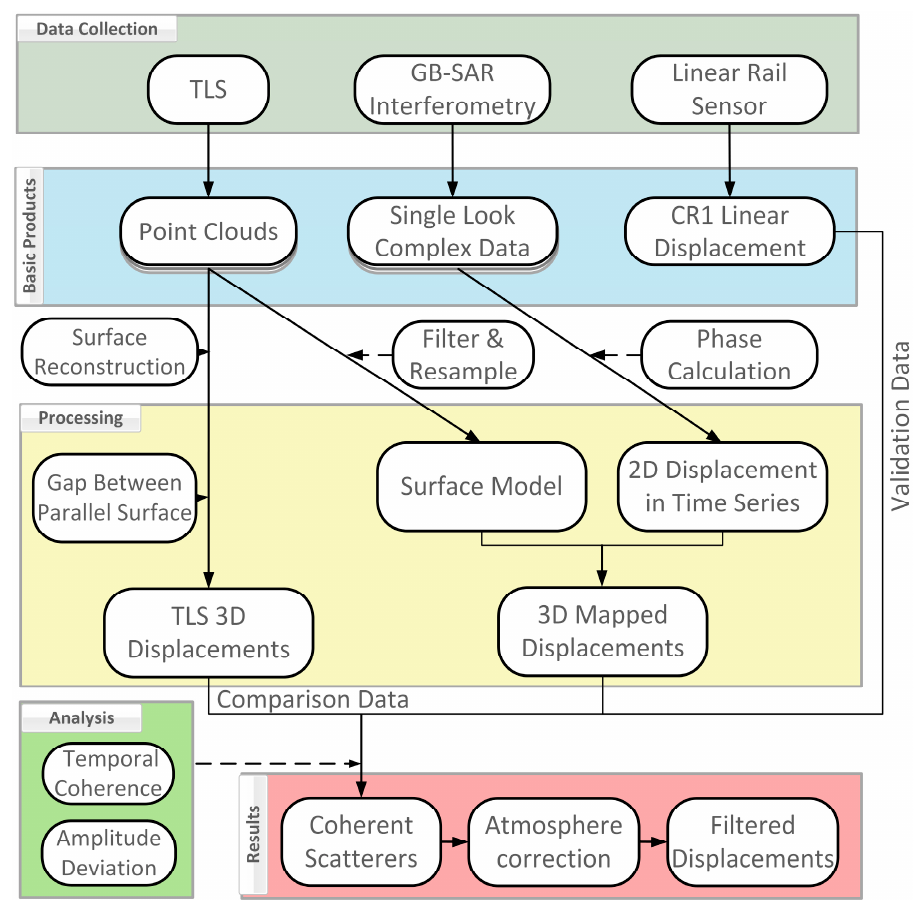
Figure 1. Experimental scheme: integrated sensors for controlled field experiment operative work flow (modified according to [24]).